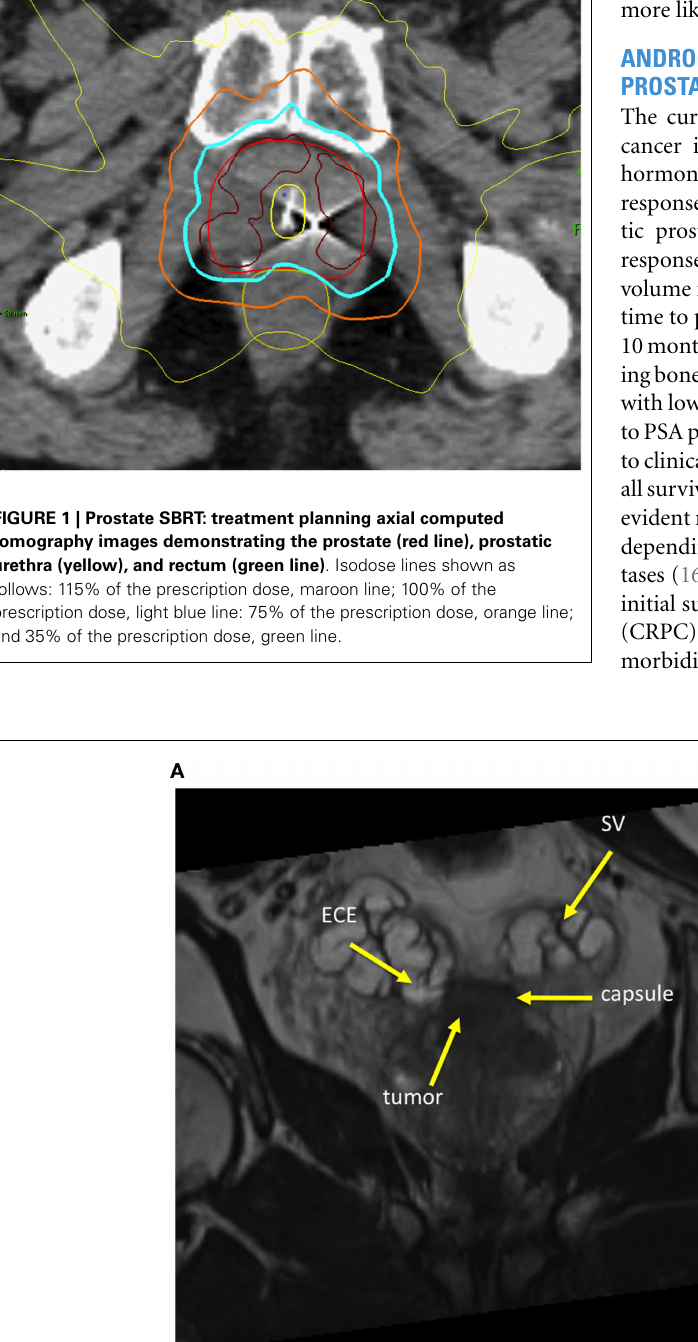
FIGURE 2 | Sixty-year-old gentleman with oligometastatic prostate cancer . He presented with back pain and his PSA was 35ng/ml. DRE was abnormal and imaging revealed: (A) CoronalT2-weighted multiplanar